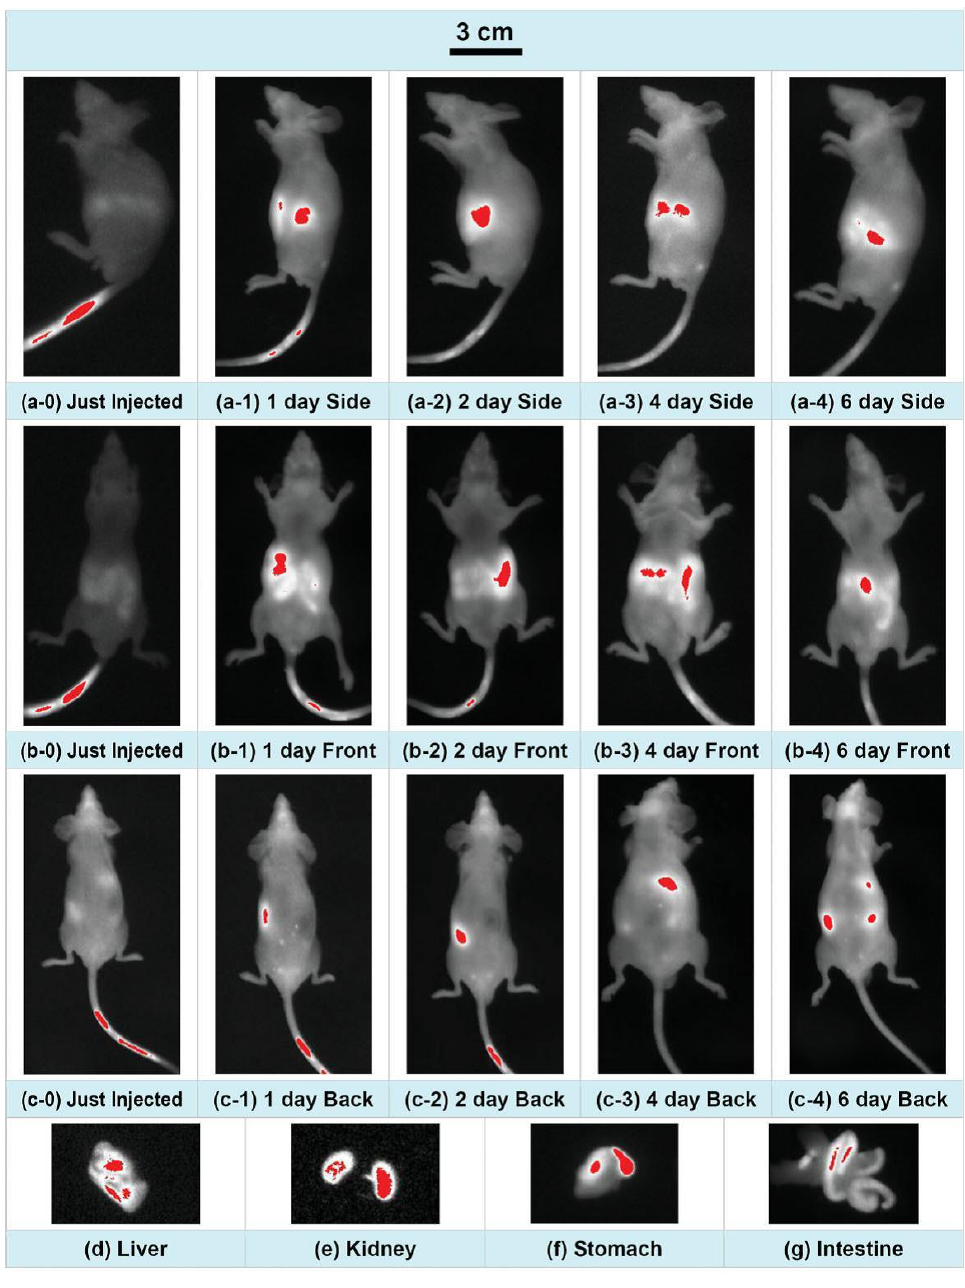
Figure 4. In vivo fluorescence images of CNT-QD IV injected into nude mice and imaged after circulation at various time intervals; ( a-0 – a-4 ) the images taken from the side of mice; ( b-0 – b-4 ) from the front of mice; ( c-0 – c-4 ) from the back of mice, and ( d – g ) organ images taken after having sacrificed the mice on the 6th day of post-injection. These pictures show prominent CNT-QD uptaking in the liver, kidney, stomach, and intestine. Reprint with permission from [60], Wiley, 2008.